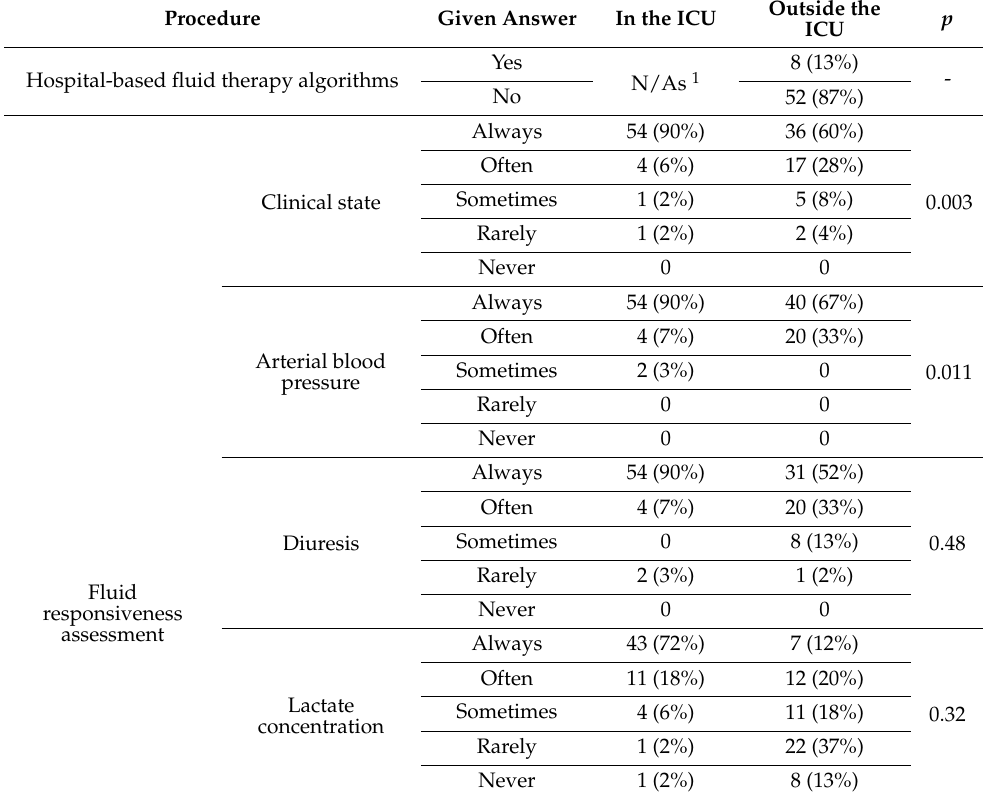
Table 3. Hemodynamic management in sepsis and septic shock—fluid responsiveness assessment and types of implemented